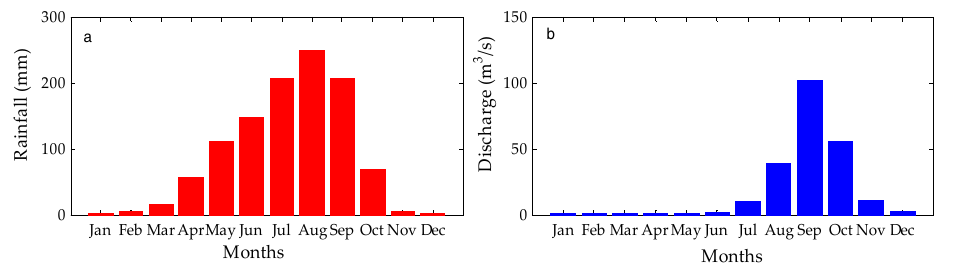
Figure 1. Study area.